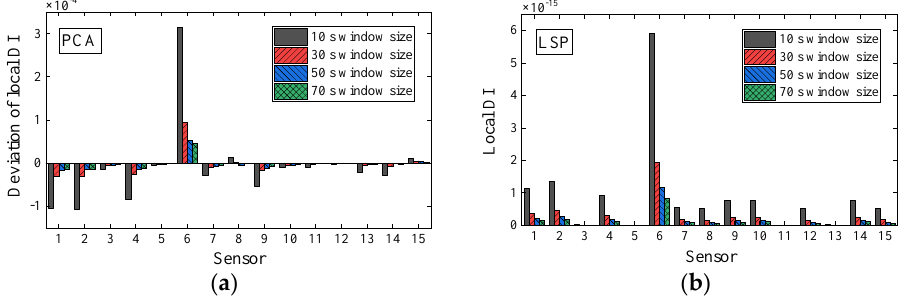
Figure 13. Deviations of local damage indicators corresponding to WPES-based ( a ) PCA and ( b ) LSP methods, respectively, when the first damage (1st DS) occurs (i.e., 111 s).